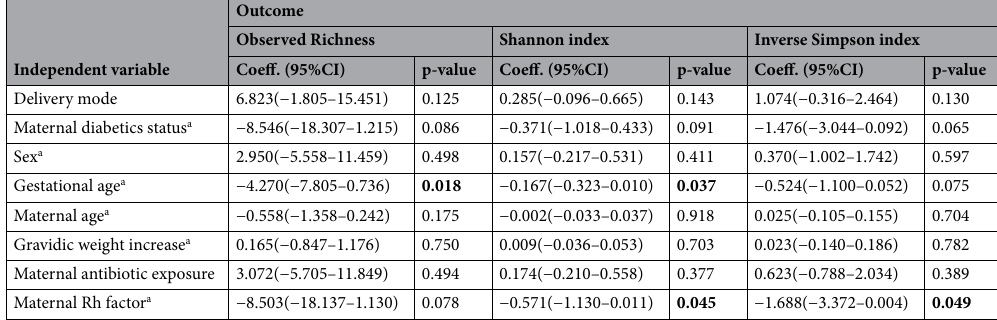
Table 2. Association between clinical and anthropometric variables and alpha diversity indexes. All analyses were adjusted for the DNA extraction batch used. Significant values are in bold.